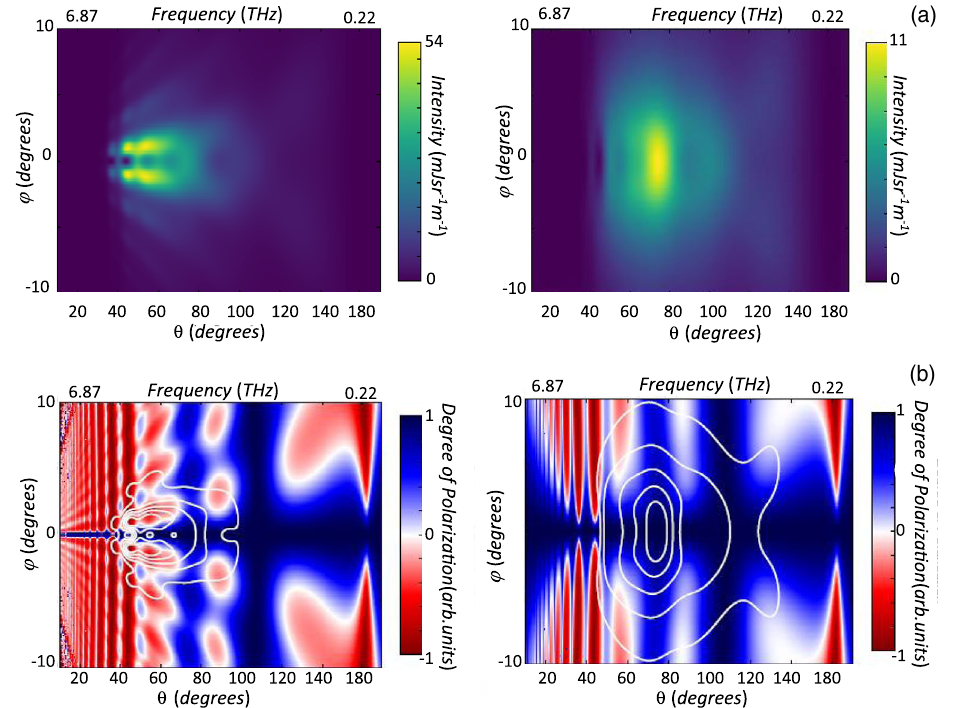
FIG. 8. The contour plots of (a) the intensities and (b) DoPs of cSPr signals over a range of observation angles ( θ ; φ ) predicted from the 1 mm period grating if 1.2 nC, 450 fs electron bunch propagates above it. The contours in (b) indicate the equal amplitude radiation intensity distributions, showing the intensity levels, as seen in (a), from the lowest to highest value with 15% step increase for each new interval. The left and the right figures were derived for an electron energy of 20.35 and 10 GeV,